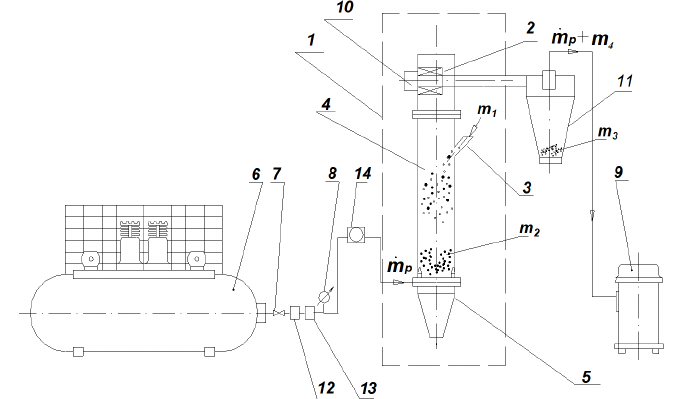
Figure 2. Scheme of experimental stand [35]. 1—turbo air classifier, 2—upper part of classifier chamber with a rotor, 3—feed inlet, 4—cylindrical part of classifier chamber, 5—conical part of classifier chamber, 6—piston compressor with expansion tank, 7—pressure reducing valve, 8—manometer, 9—vacuum cleaner, 10—electric motor, 11—cyclone, 12—air-oil separator, 13—compressed air dryer, 14—flowmeter, m 1 —feed mass, m 2 —coarse product mass, m 3 —fine product mass from the cyclone, m 4 —fine product mass from the filter, 𝑚(cid:4662) (cid:3043) —air mass flux.